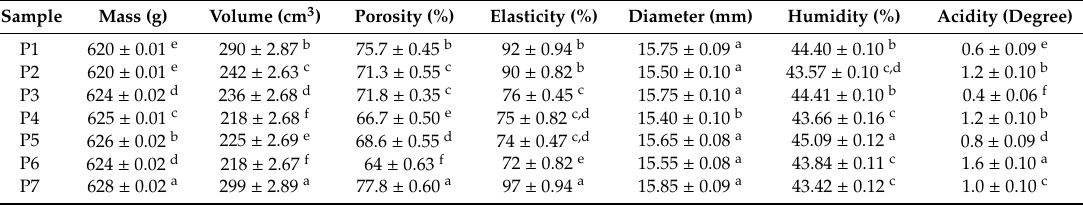
Table 7. Physico-chemical results for the experimental bread samples.